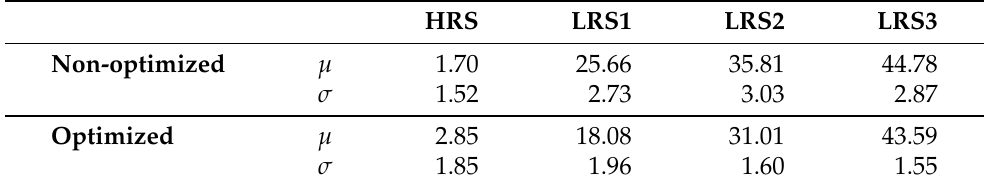
Table 2. Average ( µ ) and standard deviation ( σ ) values (in µ A) of the Gaussian fits for each conductive level for the non-optimized and the optimized operation scheme,